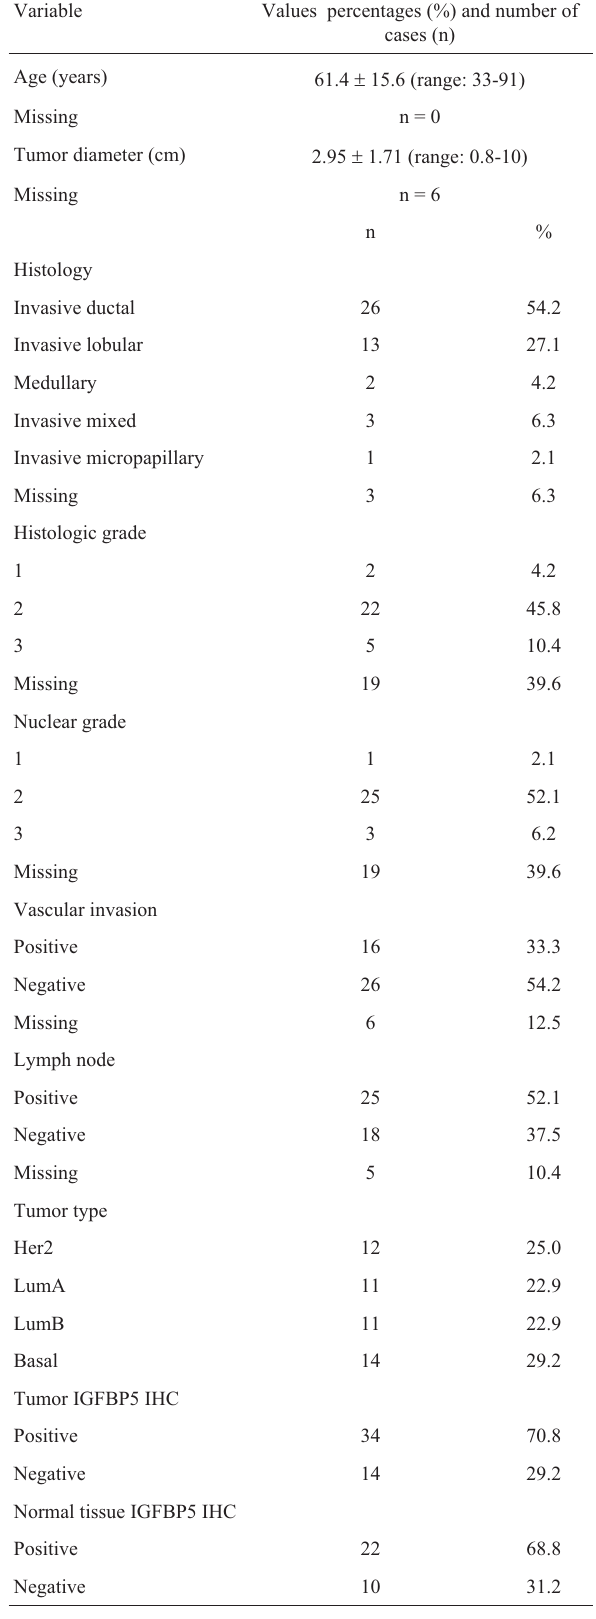
Table 2 - Patient demographics and tumor characteristics.